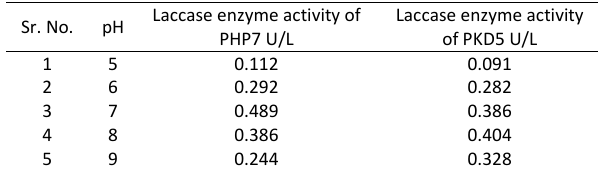
Table 6: Biomass of PHP7 and PKD5 at different temperature Table 6. Biomass of PHP7 and PKD5 at different Biomass of PHP7 at different temperature Sr. No.